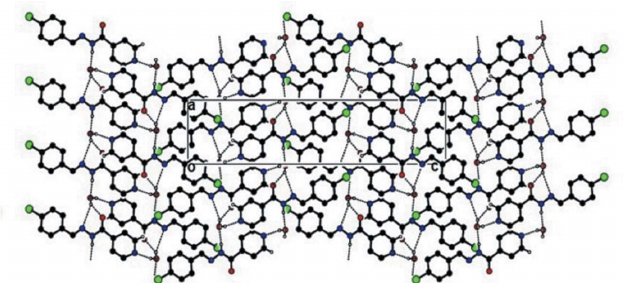
Figure 2 Part of the crystal structure with hydrogen bonds shown as dashed lines.